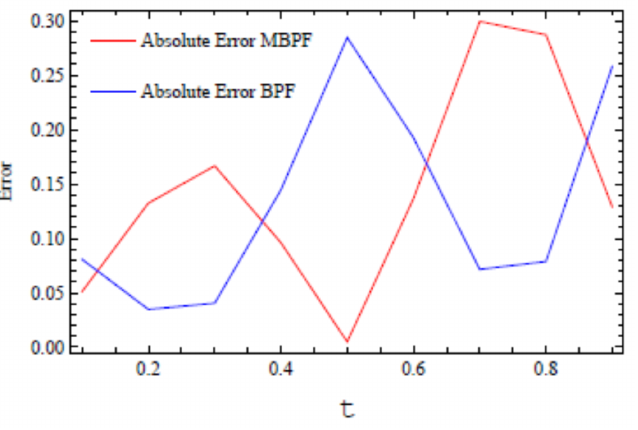
Figure 4. The absolute error of IBPFs and BPFs expansions comparison at random points. Table 1. The numerical results of example 1 at m = 16 and